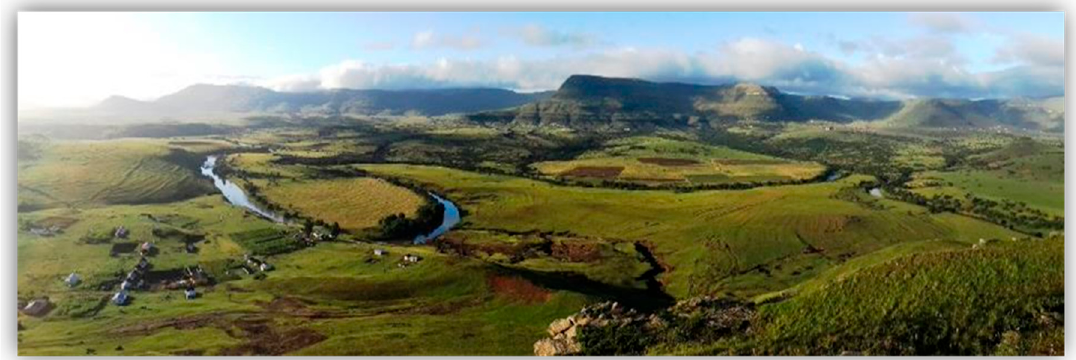
Figure 2. View over the Shukunxa village, one of the villages in the Tsitsa River Catchment (Photograph credit: Dylan Weyer).